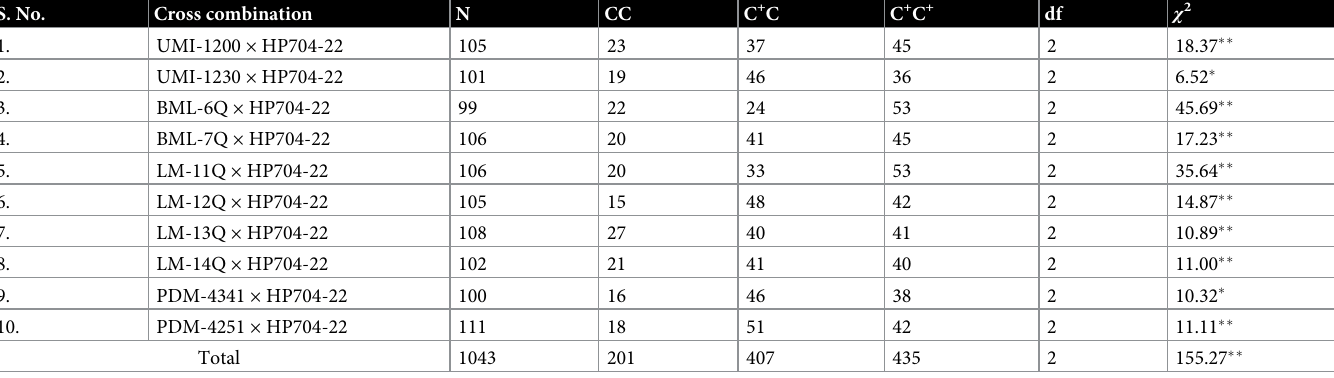
Table 1. Segregation pattern of crtRB1 gene in F 2 populations across the crosses.